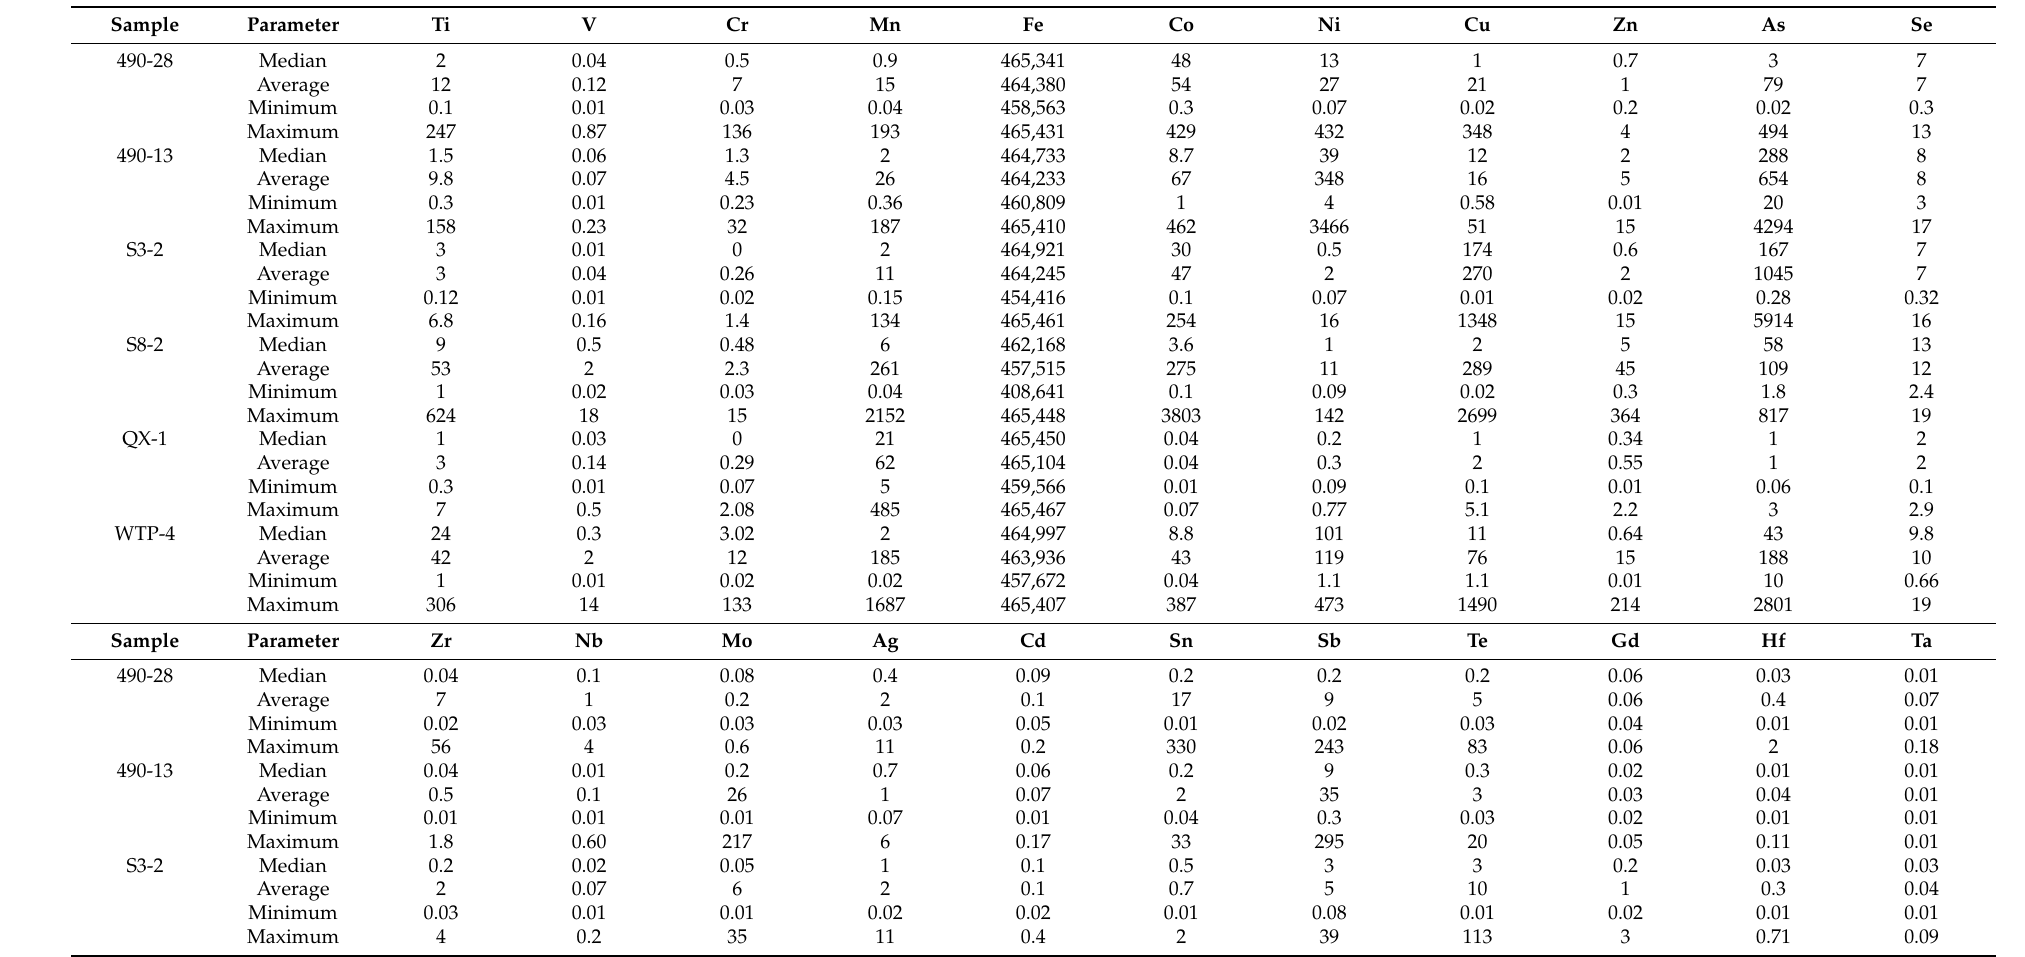
Table 4. Trace element content of pyrite from each zone (unit: